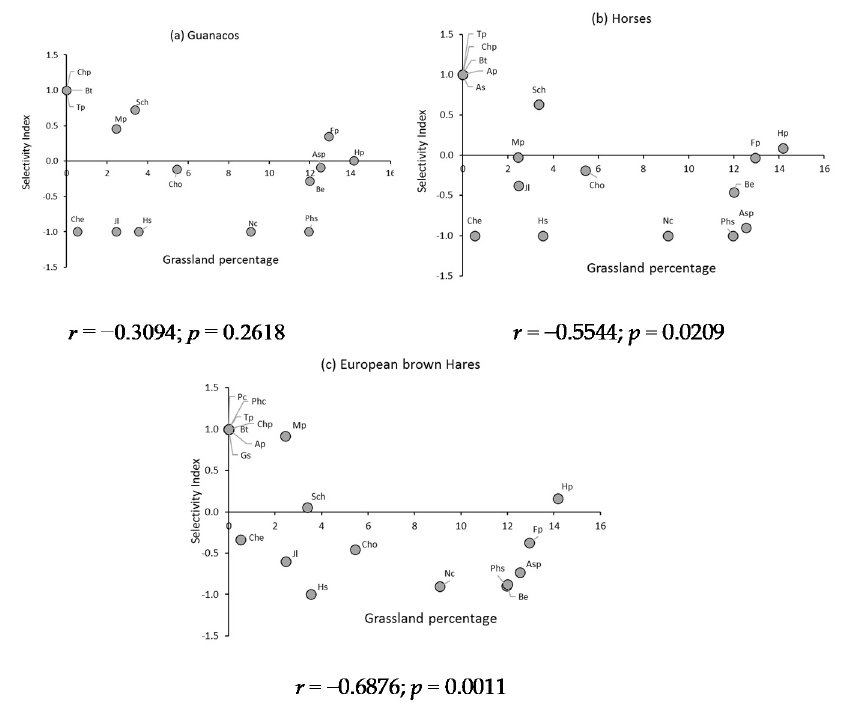
Figure 6. Ivlev’s selectivity index for the main plant species of ( a ) guanacos, ( b ) horses, and ( c ) European brown hare’s diets, in dryland grasslands. Average values of two summer evaluation seasons. Bromus tunicatus (Bt) , Festuca panda (Fp) , Stipa chrysophylla (Sch) , Trisetum preslei (Tp) , Hordeum pubiflorum (Hp) , Arenaria serpens (As) , Arjona patagonica (Ap) , Chaetanthera euphrasioides (Che) , Chaetanthera pulvinata (Chp) , Glandularia sulphurea (Gs) , Jaborosa laciniata (Jl) , Montiopsis potentilloides (Mp) , Perezia carthamoides (Pc) , Phacelia cumingii (Phc) , Phacelia secunda (Phs) , Adesmia sp. (Asp) , Berberis empetrifolia (Be) , Chuquiraga oppositifolia (Cho) , Nassauvia cumingii (Nc) , Haplopappus scrobiculatus (Hs).